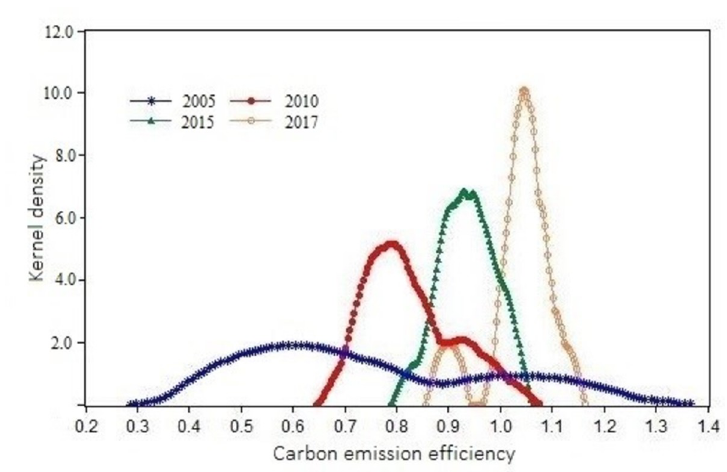
Fig 6. Dynamic evolution characteristics of carbon emission efficiency in